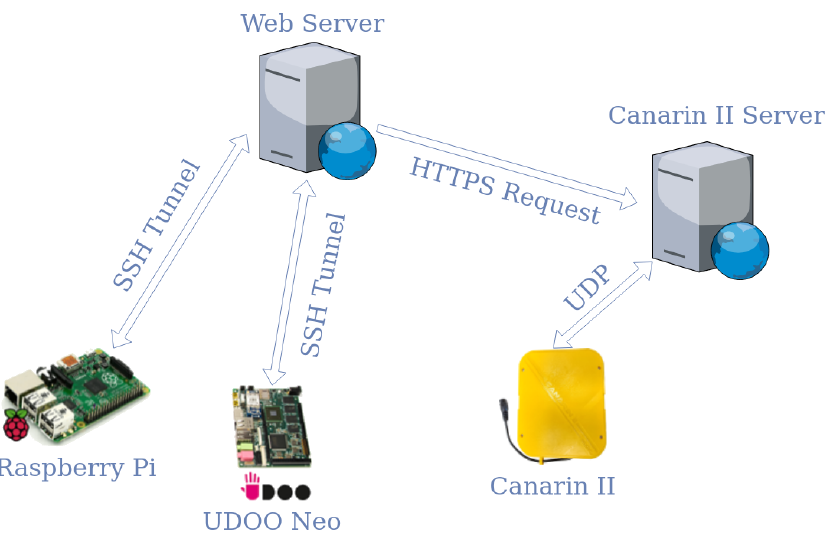
Figure 1. RaveGuard experimental